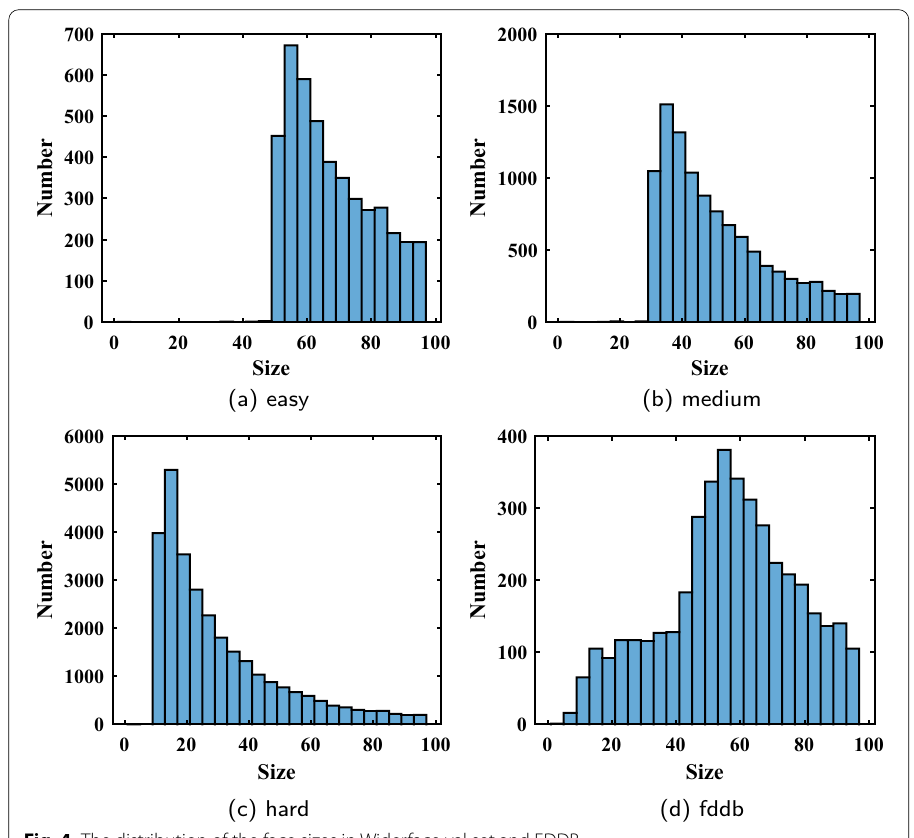
Fig. 4 The distribution of the face sizes in Widerface val set and